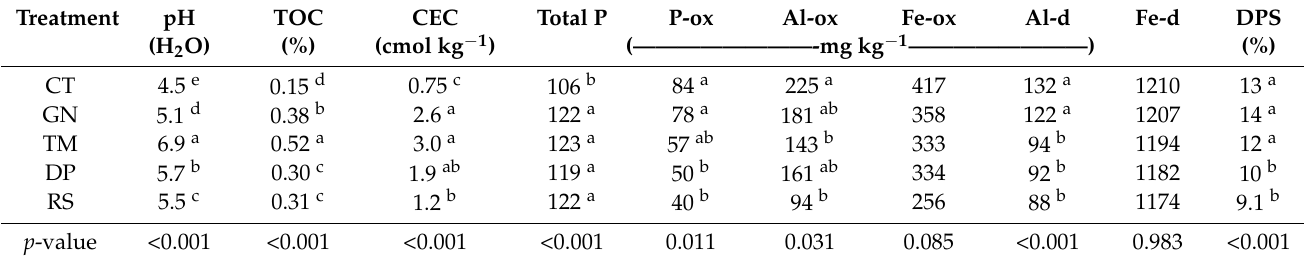
Table 2. Mean values for the selected chemical properties of sandy soils, which had been incorporated by organic residues of different biochemical quality 1